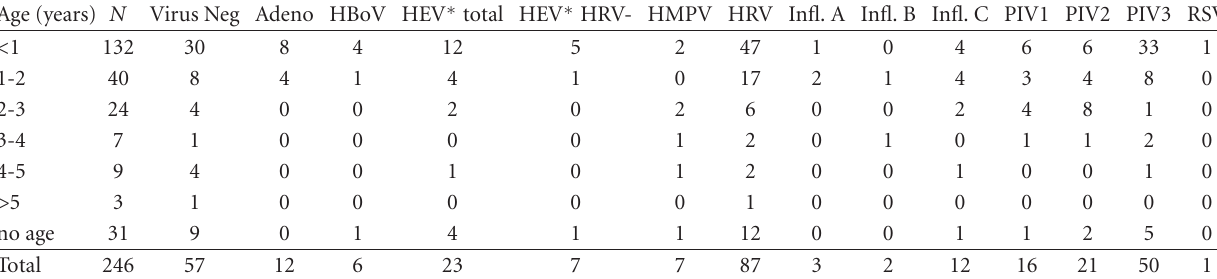
Table 1: Distribution of viral pathogens according to the age of the